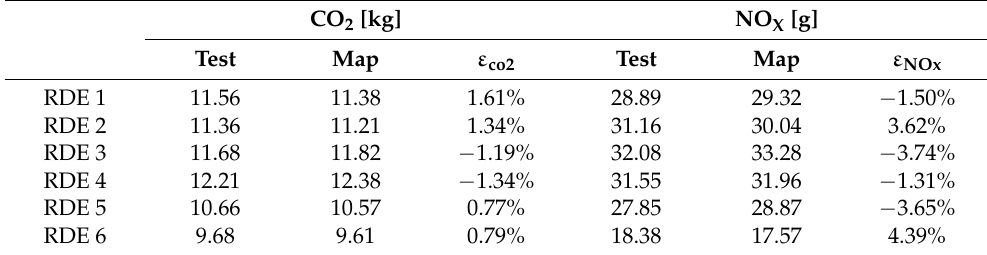
Table 7. CO 2 and NO X pollutants from RDE cycles versus map